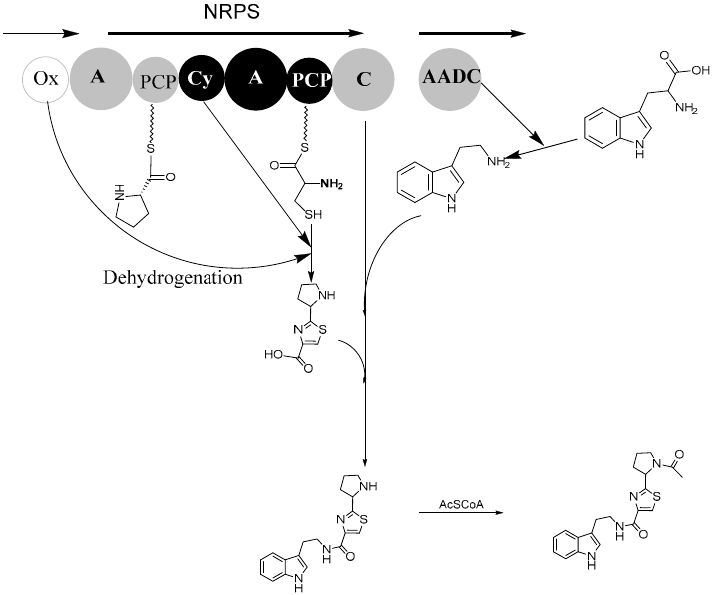
Figure 3. The plausible biosynthesis pathway of bacillamide F. The biosynthetic process of NRPS (EIM09914.1, bacitracin synthetase) domains, Ox (oxidase domain, EIM09913.1), and AADC (aromatic L-amino acid decarboxylase) domain were involved in the synthesis of bacillamide F. Each circle represents an NRPS enzymatic domain, from left to right: A, adenylation domain, Cy, cyclization domain. C, condensation domain, and PCP, peptidyl carrier protein domain.